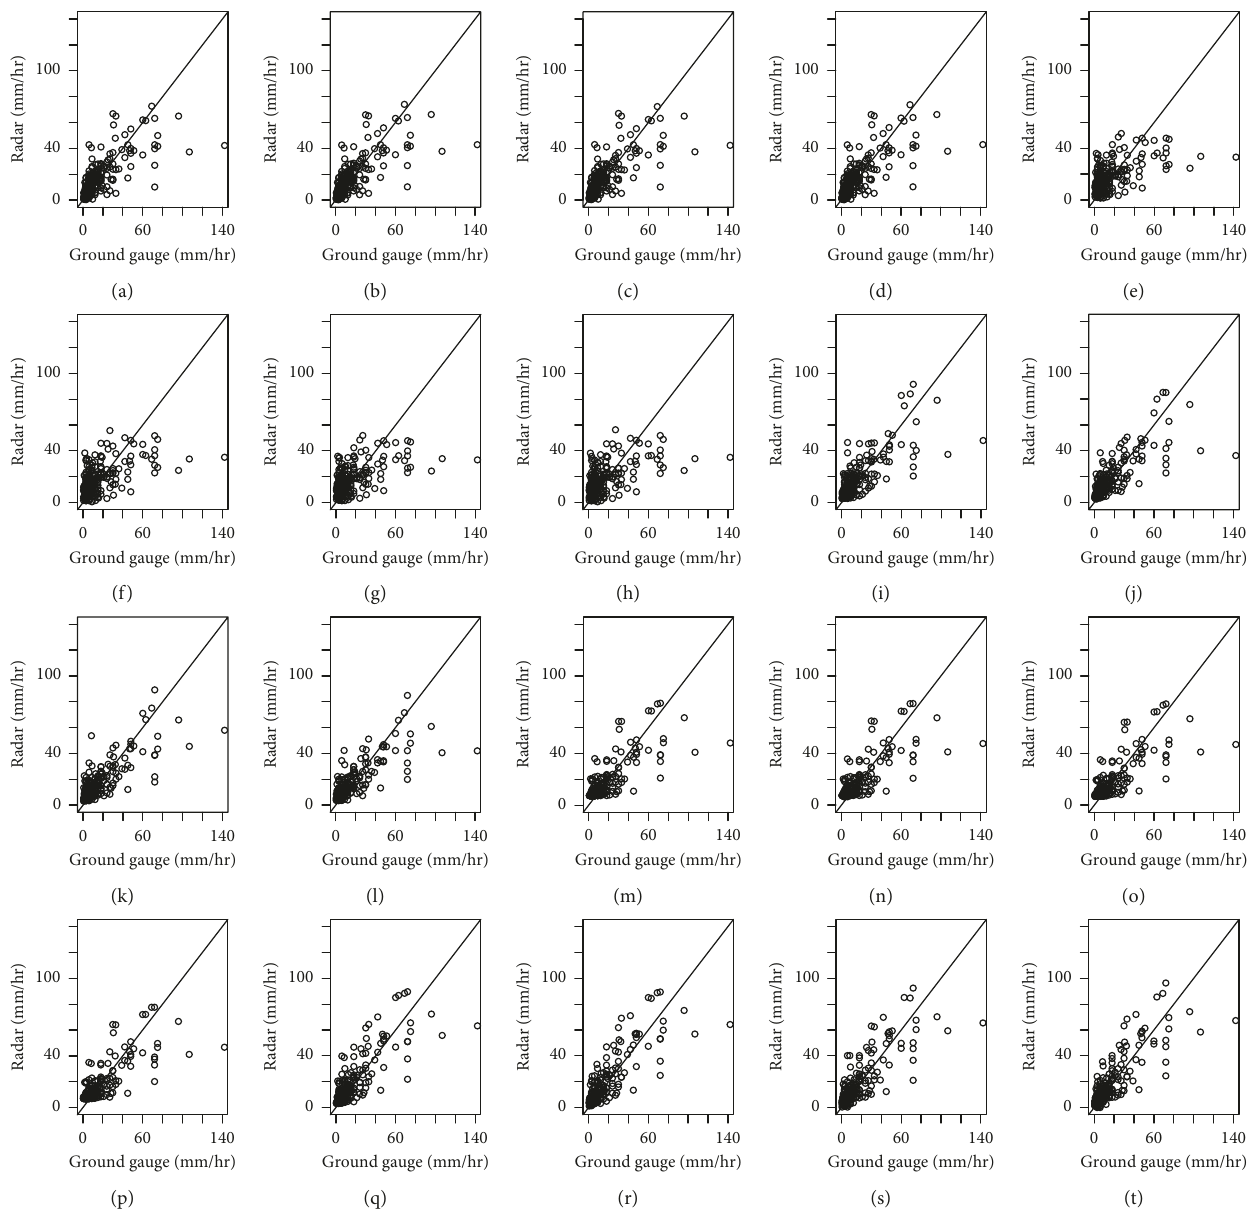
Figure 5: Plots of rainfall rate estimations versus observations of tested models for precipitation event #1. (a) ZR1-L1 (RMSE:11.97, R : 0.75). (b) ZR2-L1 (RMSE:11.91, R : 0.75). (c) ZR3-L1 (RMSE:11.98, R : 0.75). (d) ZR5-L1 (RMSE:11.92, R : 0.75). (e) ZR1-L0 (RMSE:14.59, R : 0.6). (f) ZR2-L0 (RMSE:14.62, R : 0.6). (g) ZR3-L0 (RMSE:14.62, R : 0.6). (h) ZR5-L0 (RMSE:14.66, R : 0.6). (i) RF1 (RMSE:11.29, R : 0.79). (j) RF2 (RMSE:11.3, R : 0.79). (k) RF3 (RMSE:11.01, R : 0.8). (l) RF5 (RMSE:11.2, R : 0.8). (m) GBM1 (RMSE:11.05, R : 0.8). (n) GBM2 (RMSE:11.05, R : 0.8). (o) GBM3 (RMSE:11.03, R : 0.42). (p) GBM5 (RMSE:11.06, R : 0.8). (q) ELM1 (RMSE:10.3, R : 0.83). (r) ELM2 (RMSE:10.11, R : 0.84). (s) ELM3 (RMSE: 10.21, R : 0.83). (t) ELM5 (RMSE: 10.06, R :